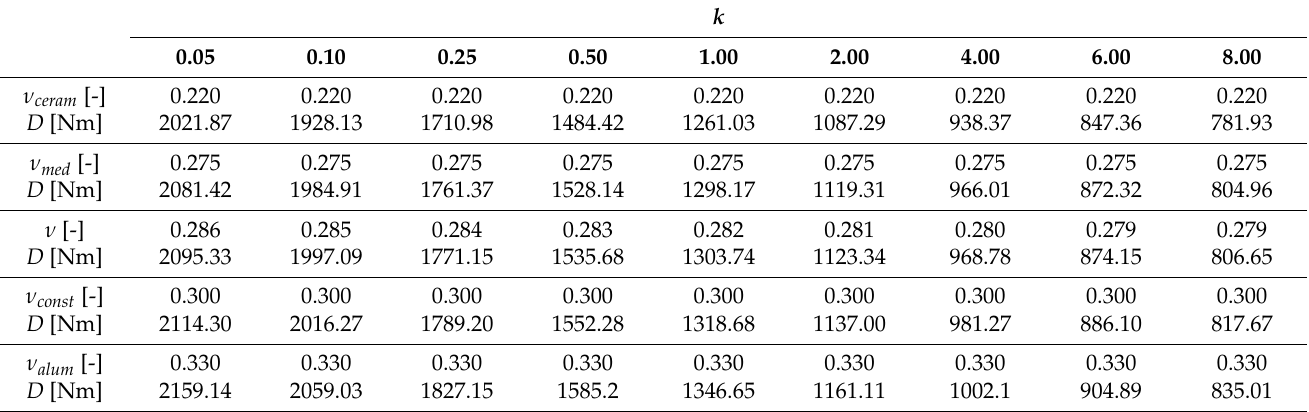
Table 4. The analytical values of bending rigidity by direct